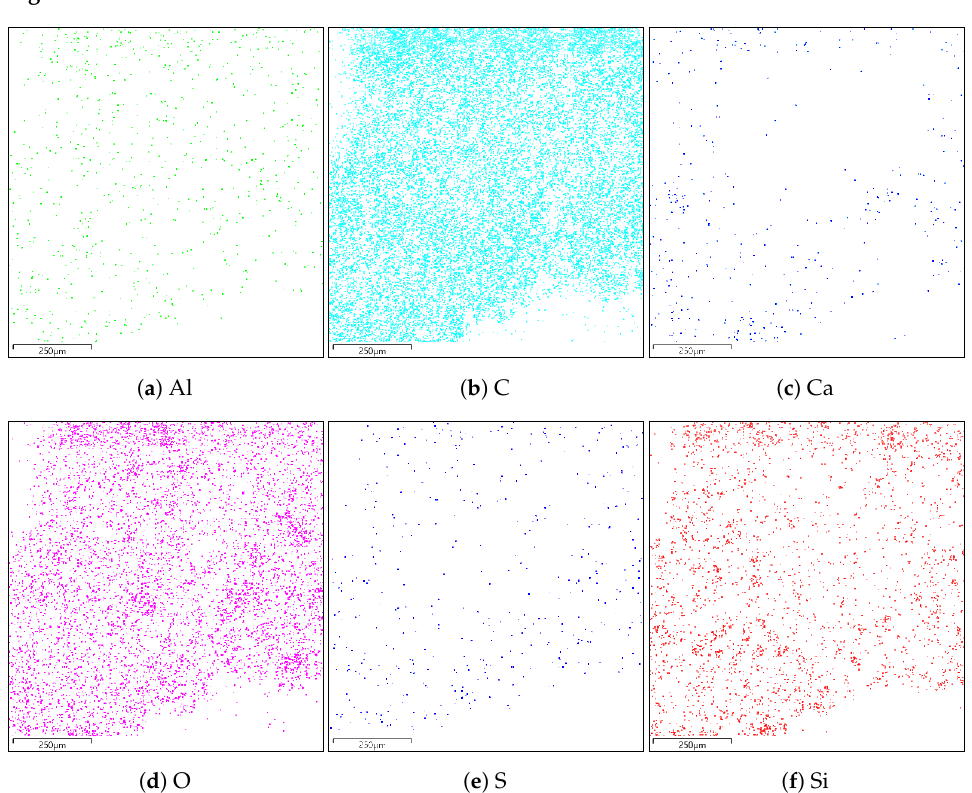
Figure 13. Distribution of individual chemical elements on the cross-sectional area in the material